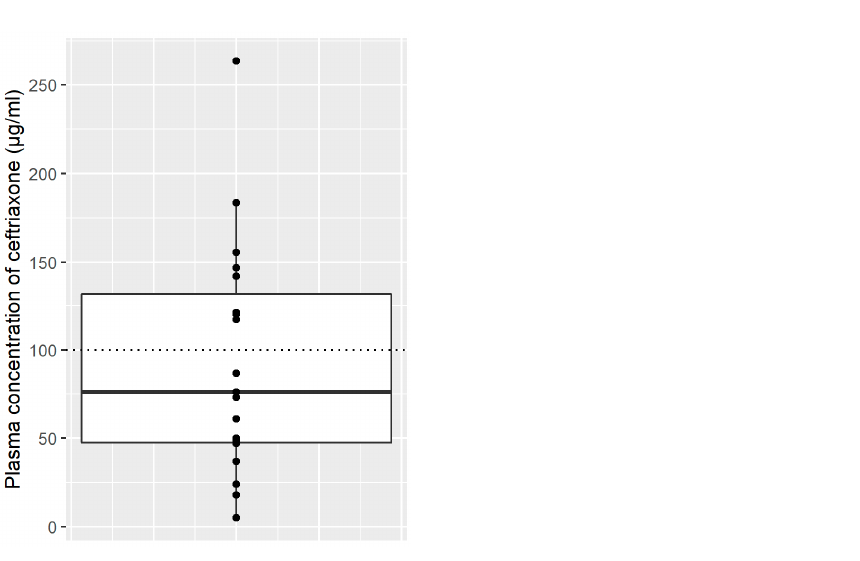
Figure 2. Plasma concentrations of ceftriaxone (µg/mL) are represented by points. The box plot represents the first and third quartiles (Q1–Q3) of plasma concentrations of ceftriaxone; the black horizontal line represents the median of plasma concentrations of ceftriaxone; the dotted line represents the toxicity level of ceftriaxone (100 µg/mL).